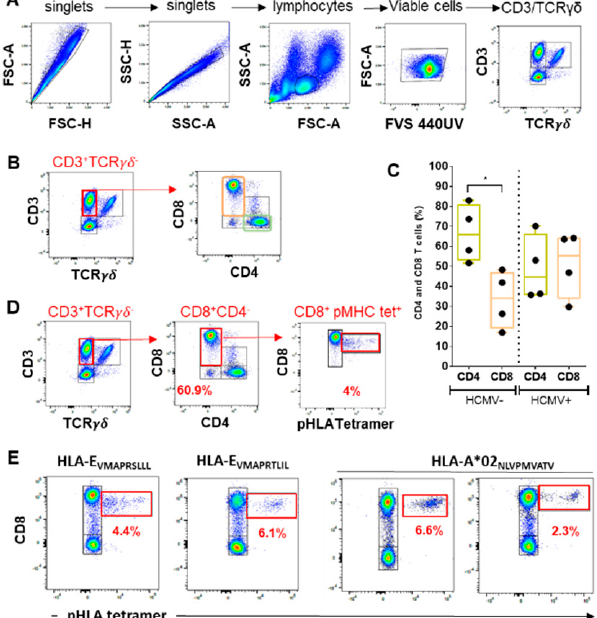
Figure 1. ( A ) A representative nested gating strategy illustrating lymphocyte population subgated by the expression of CD3 and γδ TCR. Cells were gated first on FSC-A vs. FSC-H plots and then on SSC-H vs. SSC-A plots to eliminate doublets. Lymphocytes were gated on an SSC-A vs. FSC-A dot plot. Viable lymphocytes were selected using fixable viability stain (FVS) 440UV staining. Lymphocytes were subgated using CD3 and γδ TCR staining. ( B , C ) Analysis of CD4 and CD8 lymphocyte subsets. A representative density plot showing CD4 and CD8 staining among the CD3 + γδ TCR- lymphocytes. ( C ) A graphical and statistical analysis of CD4 and CD8 lymphocyte subsets from independent HCMV − ( n = 4) and HCMV + ( n = 4) individuals. ( D , E ) Detection and quantification of peptide-specific conventional and non-conventional CD8 T cell populations using HLA class I /peptide tetramers (pHLA). Representative detection of anti-HCMV peptide-specific, conventional (HLA-A2 pp65, peptide NLVPMVATV) and two unconventional (HLA-E UL40, peptides VMAPRSLLL and VMAPRTLIL), CD8 T cells from three HCMV + hosts is shown. The percentages of tetramer positive cells (tet+) among total CD8 T cells are indicated. FSC-H: Forward scatter height. FSC-A: Forward scatter area. SSC: Side scatter. TCR: T cell receptor. p value: * for p < 0.05.